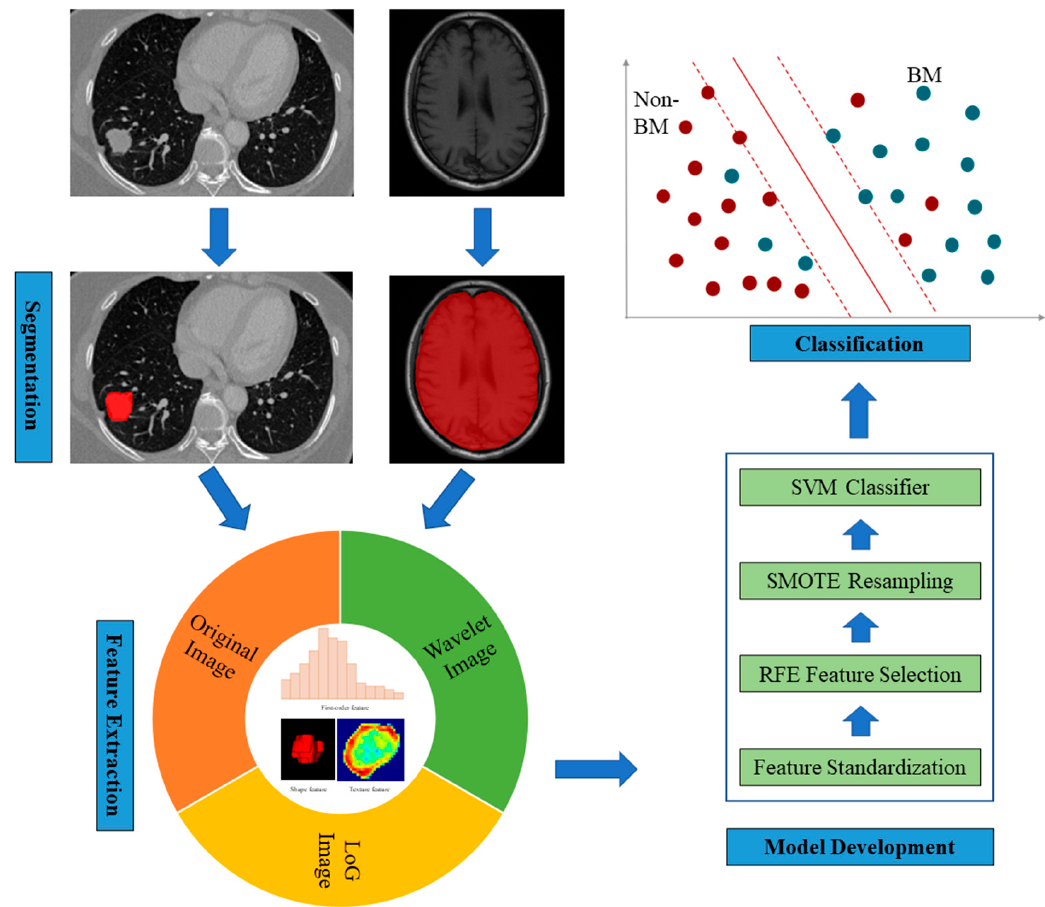
Figure 1. Illustration of the radiomics model development procedures.